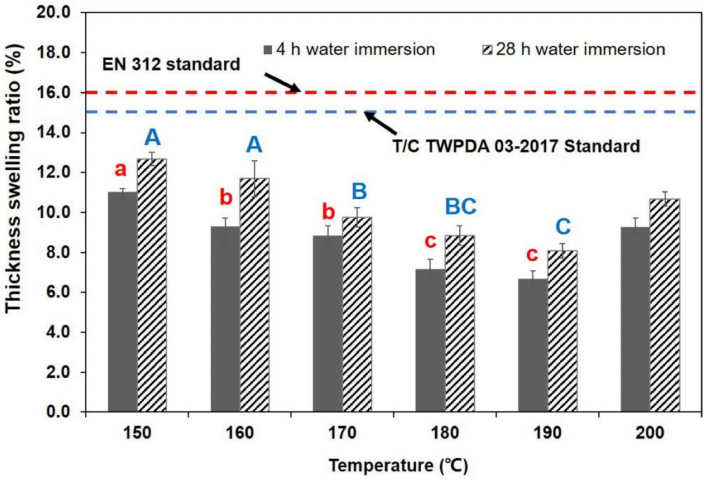
Figure 2. Thickness swelling results at different hot press temperatures. (Notes: The same lowercase (4 h water immersion) and capital letter (28 h water immersion) are not significantly different at 5% significance level using Duncan’s post-hoc test).